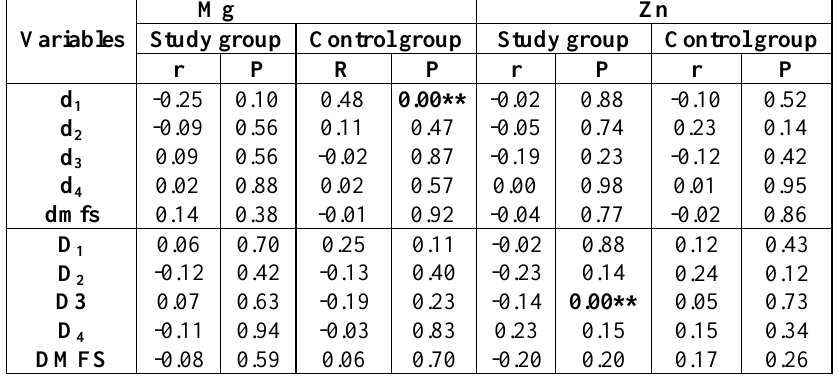
Table 4: Correlation coefficient between salivary magnesium and zinc and caries experience among study and control groups (ds grades, dmfs, DS grades and DMFS)